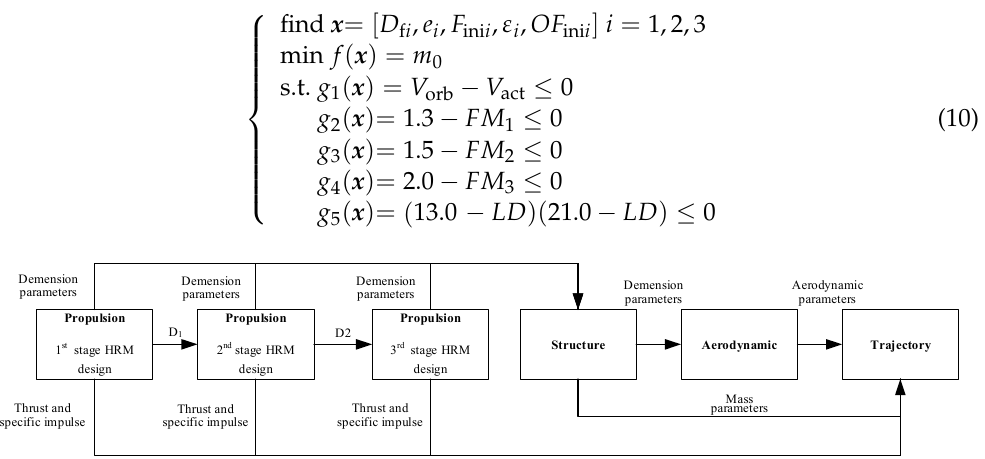
Figure 13. Serial design strategy of LV design.